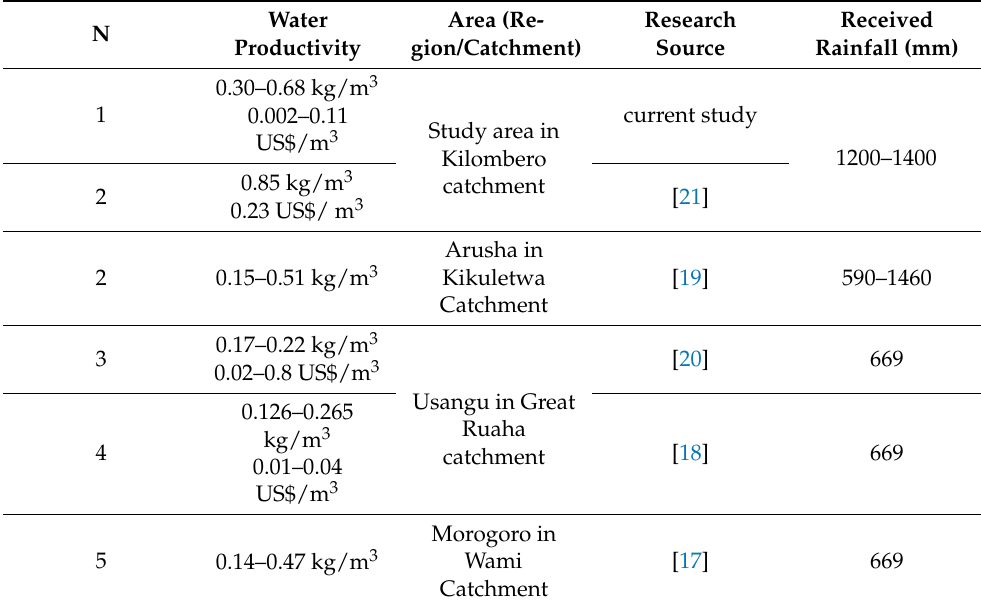
Table 7. Comparison of water productivity values for paddy in Tanzania.